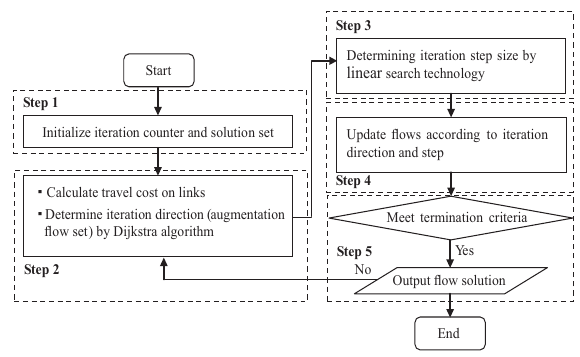
Fig. 2. Solution procedure for elastic-demand SUE